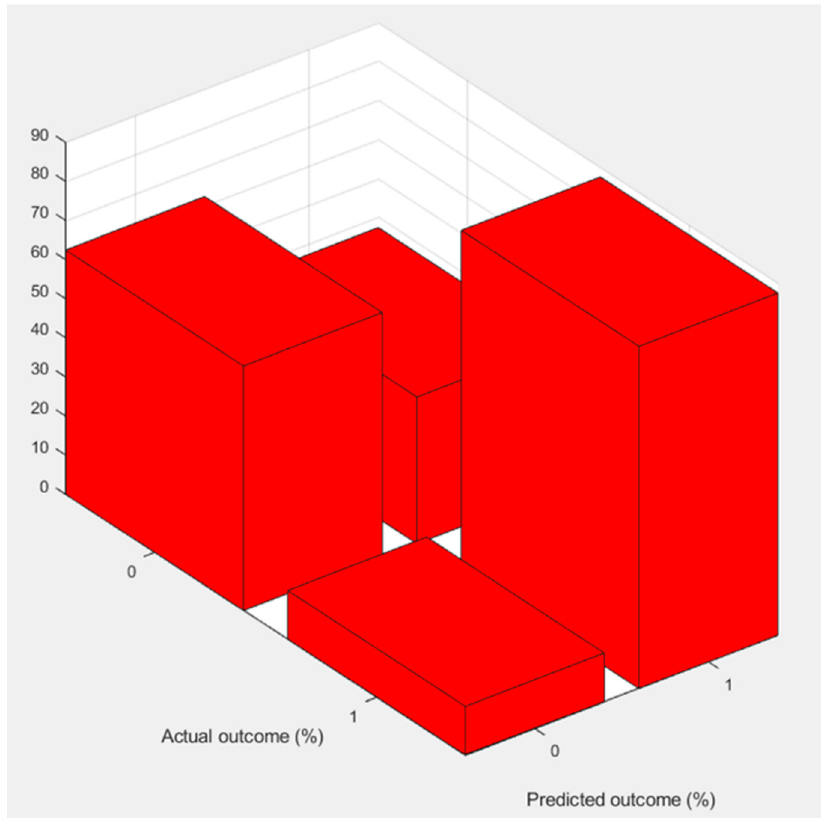
Figure 3. Confusion matrix for the selected classifier.